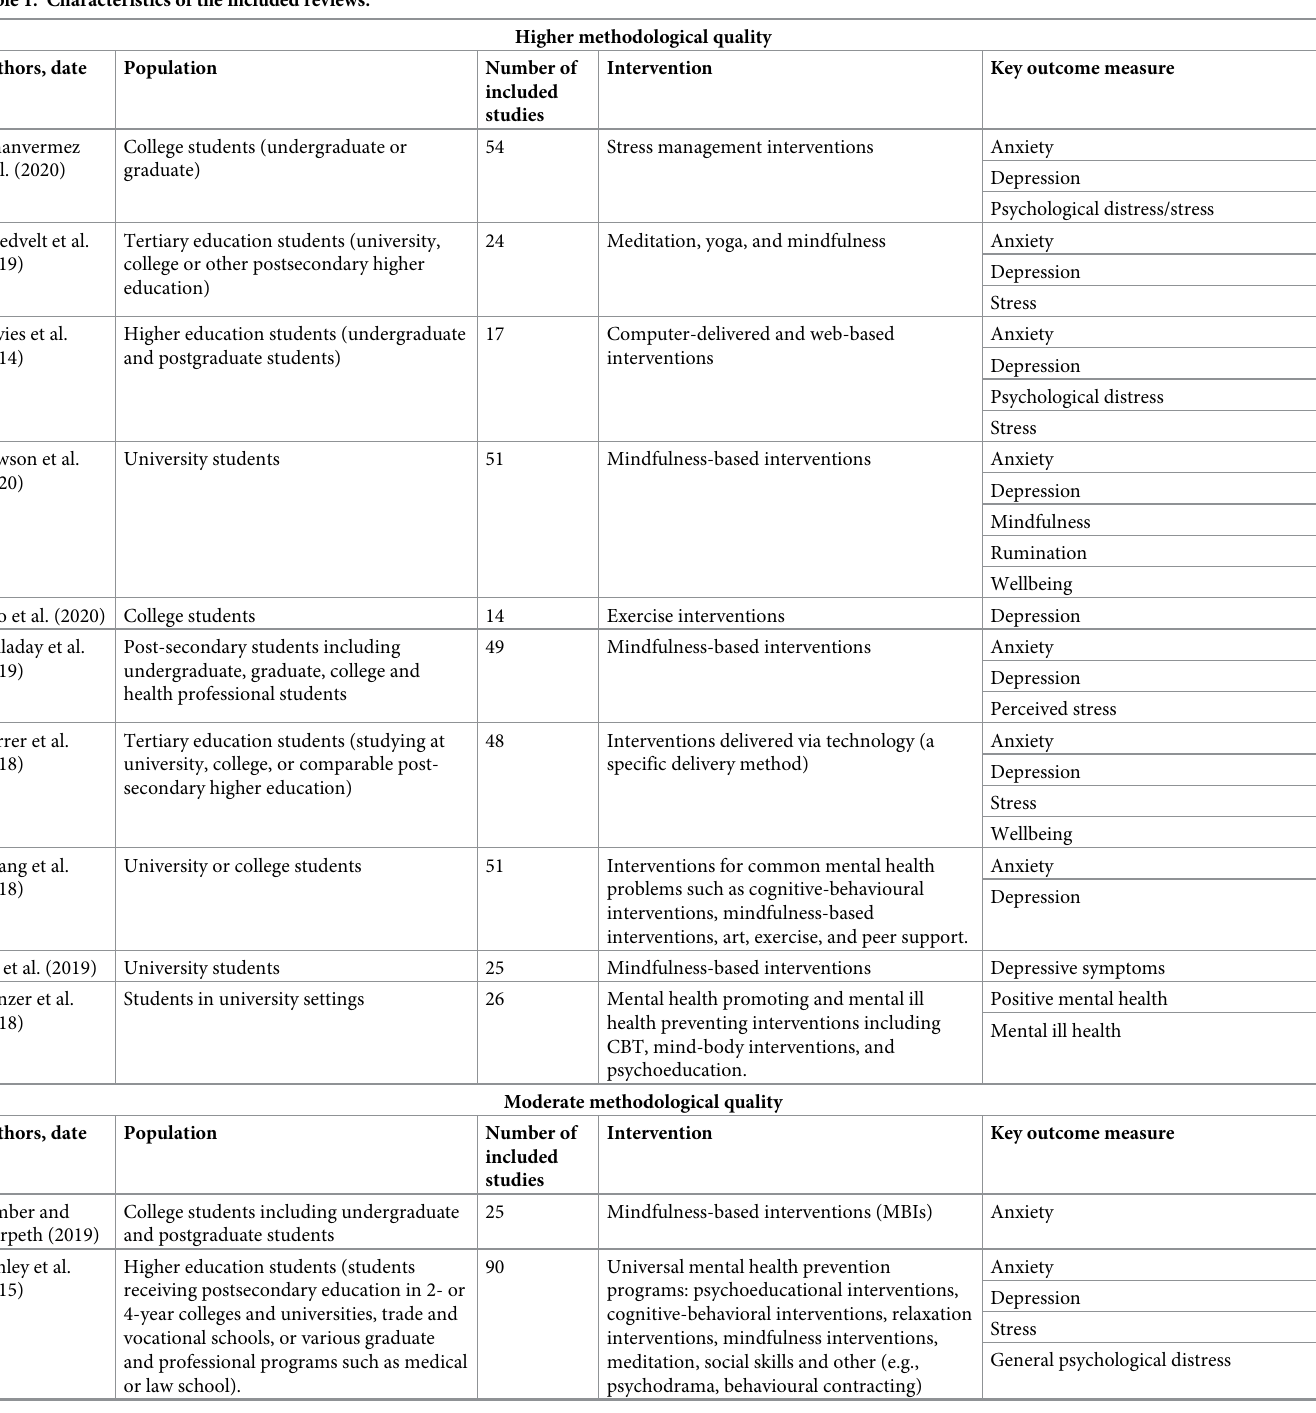
Table 1. Characteristics of the included